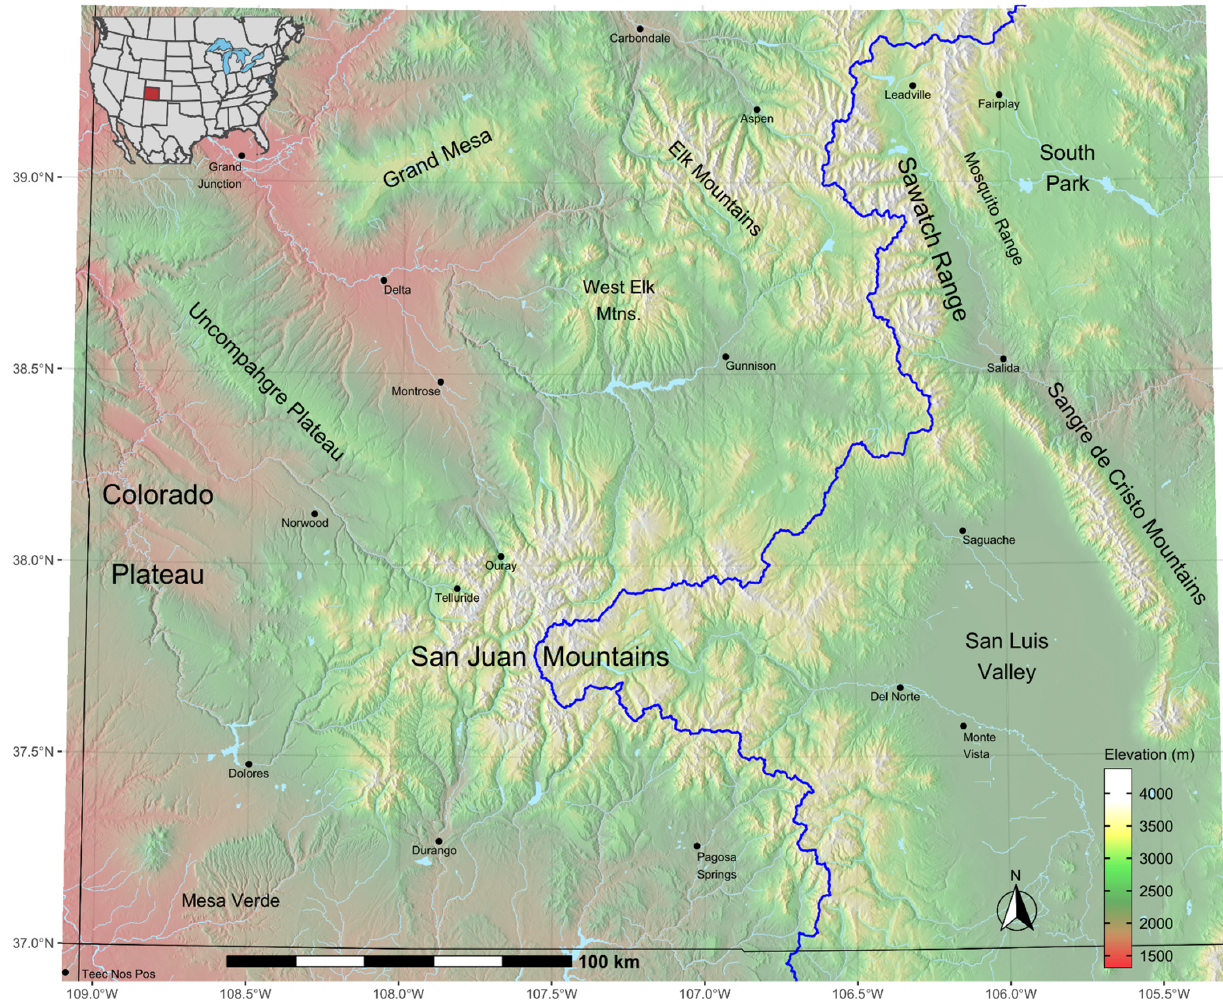
Figure 1. Modeled study area in the Southern Rocky Mountains, southwestern Colorado. Blue line is the Continental Divide. Area is 94,238 km 2